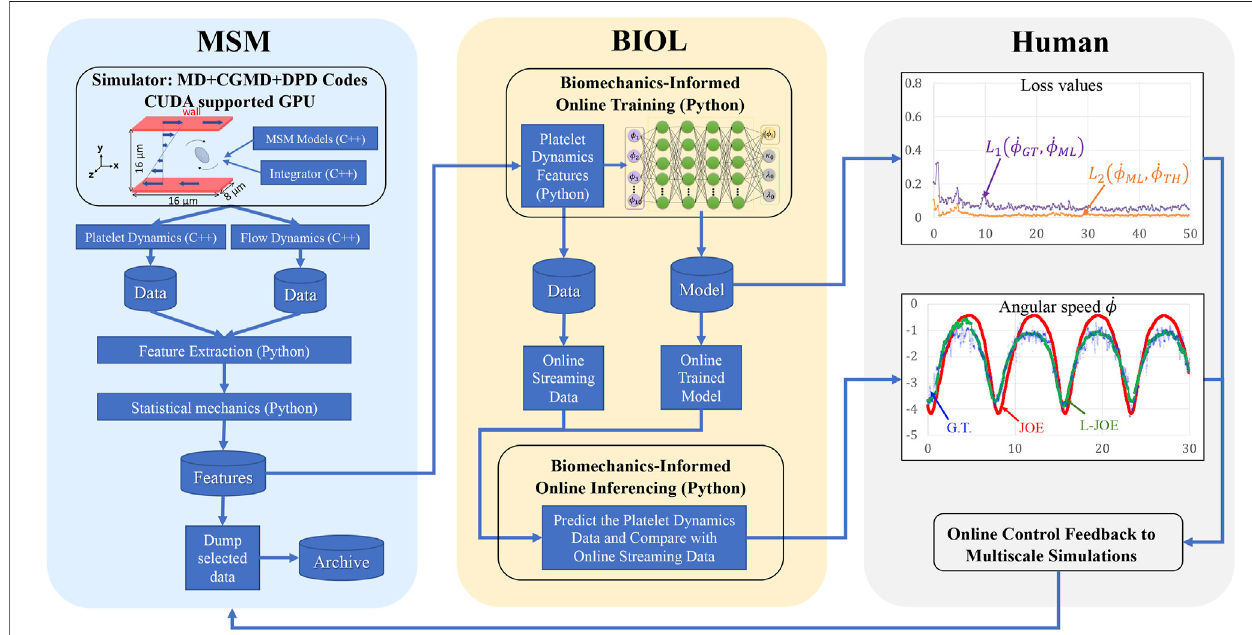
FIGURE 5 | Work fl ow for integrated MSM and BIOL. The MSM simulator is implemented by C++ and extracted data are processed by Python. Speci fi c features relatedtoplateletrotation, e.g. ,rotationangleandangularspeed,arerandomlysampledtofeedintoBIOLforsolvingequationsofmotionintimeforsimulation.Ahuman, as an external intelligent side, controls the learning frequency and feedback to MSM with online